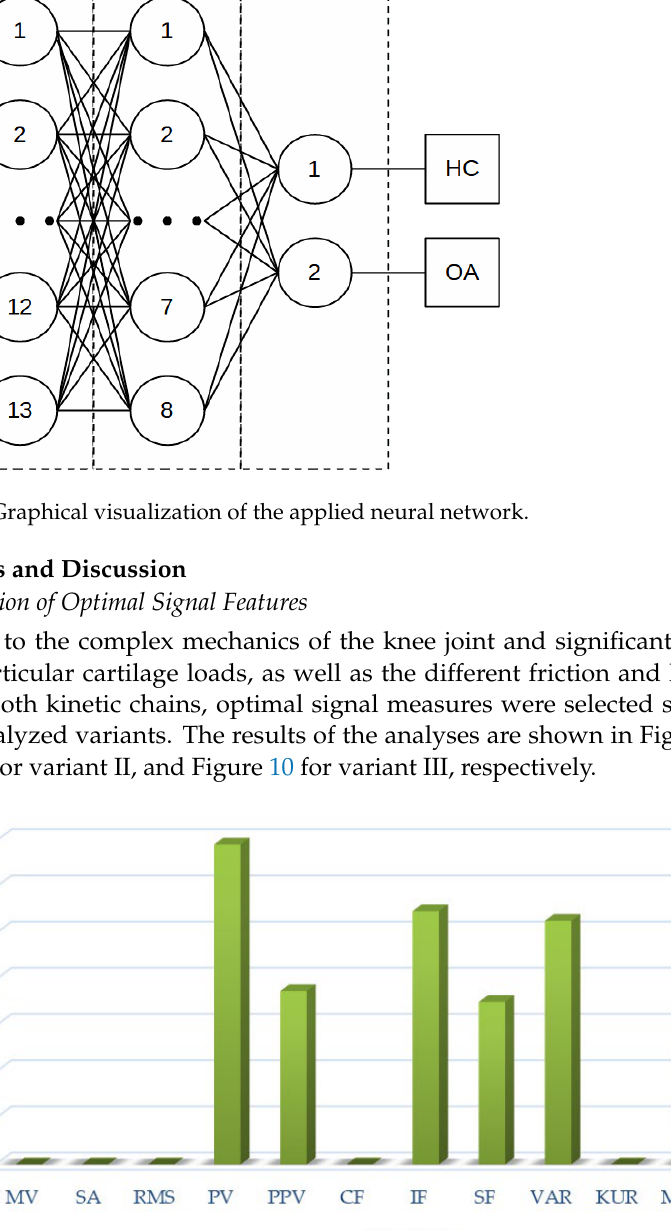
Figure 9. Selection of optimal features for variant II (CKC) . For variant II, the following measures of acoustic signals were selected based on the analyses performed: mean value, straightened average value, peak value, peak-to-peak value, impact factor, shape factor, variance, M6A , and M8A . These measures were used as input data in the variant II classification.